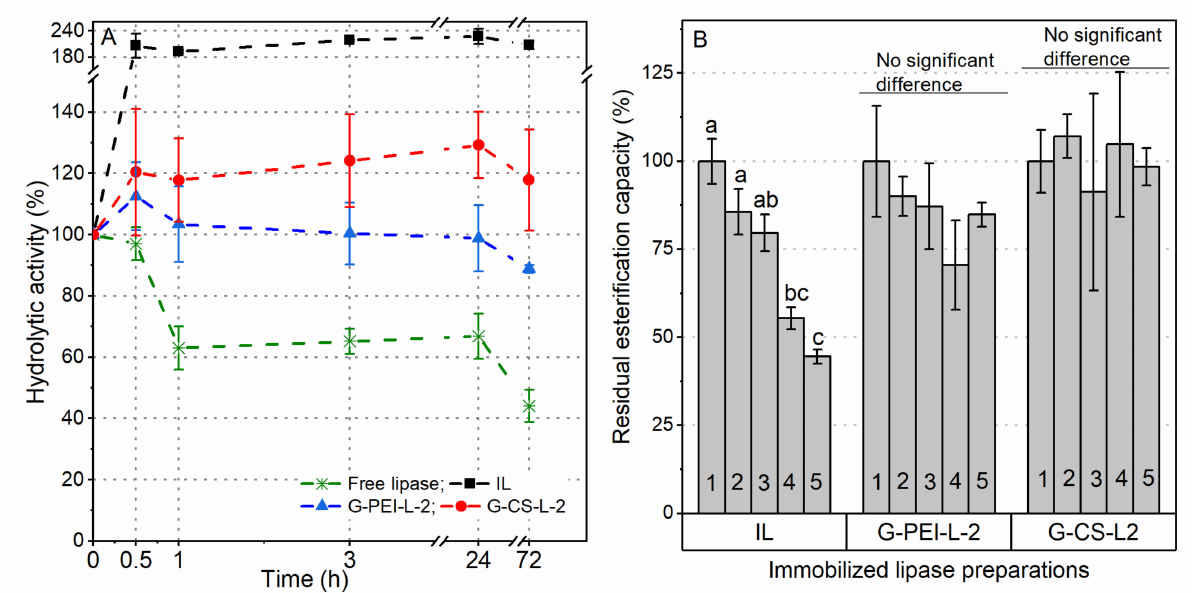
Figure 9. Stability of free and immobilized lipase preparations at 50 ◦ C with the incubation period up to 72 h ( A ); the reusability of immobilized lipase preparations ( B ). Different lowercase letters indicate significant differences among different reaction cycles for each biocatalyst ( p <